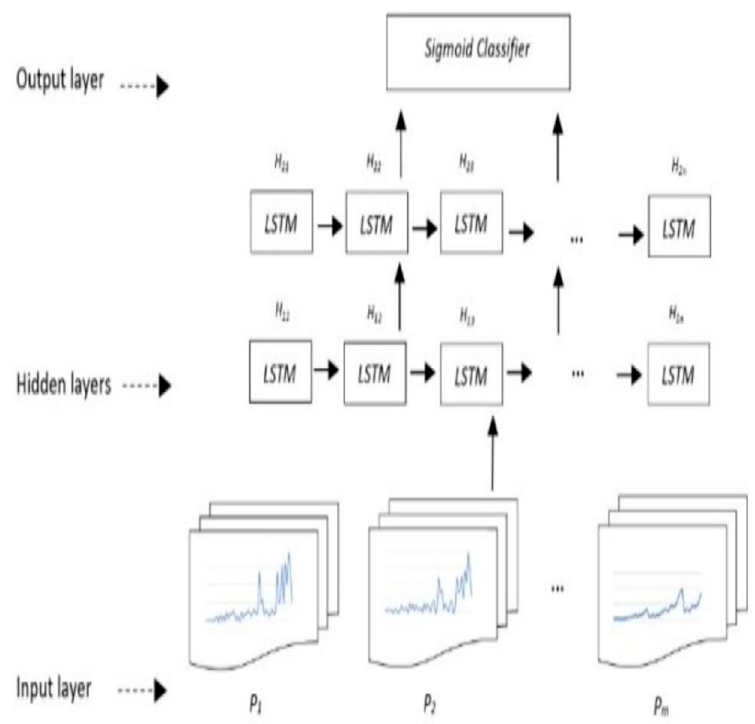
Figure 2. An overview of the LSTM network used in this study.